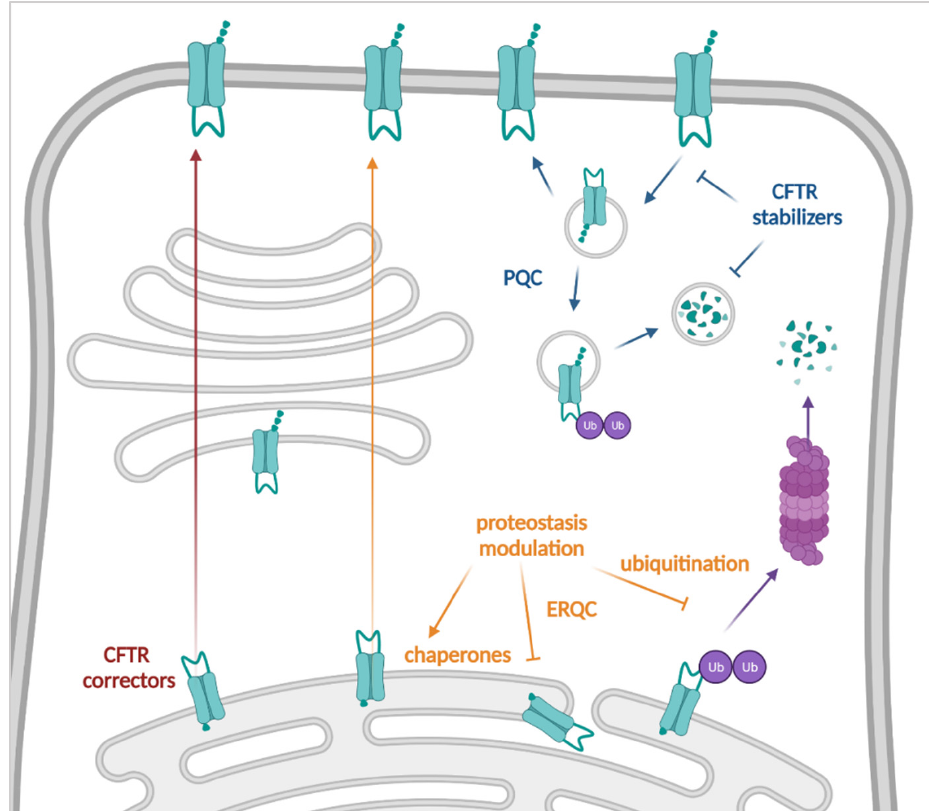
Figure 4. Strategies to improve the amount of CFTR channels at the plasma membrane (PM). CFTR correctors (red) interact directly with CFTR to improve its folding and subsequent trafficking. Targeting CFTR interactors through proteostasis modulation (orange) allows mutant CFTR to escape early degradation and traffic to the PM. Stabilizers (blue) prolong the duration of CFTR’s residence at the PM by slowing down its turn-over and peripheral degradation. ERQC: Endoplasmic Reticulum Quality Control; PQC: Peripheral Quality Control.